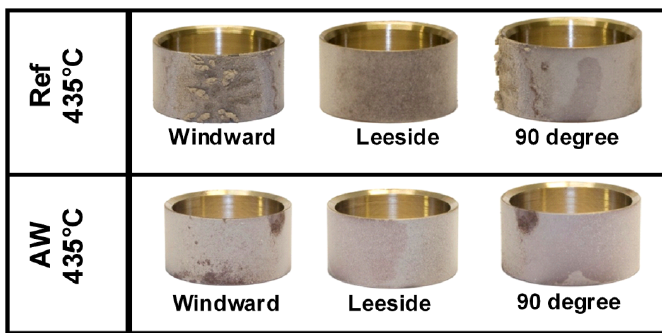
Figure 4. Deposit formed on the